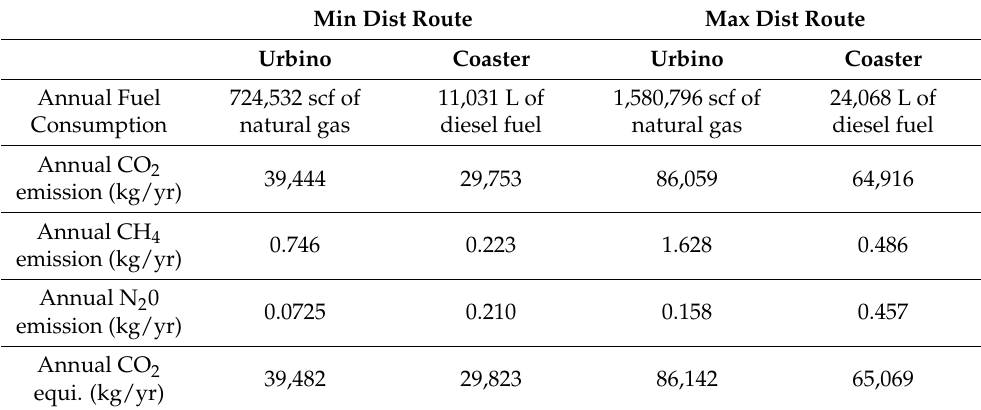
Table 6. C0 2 , CH 4 and N 2 0 emissions of electric and diesel buses during the operational stage.